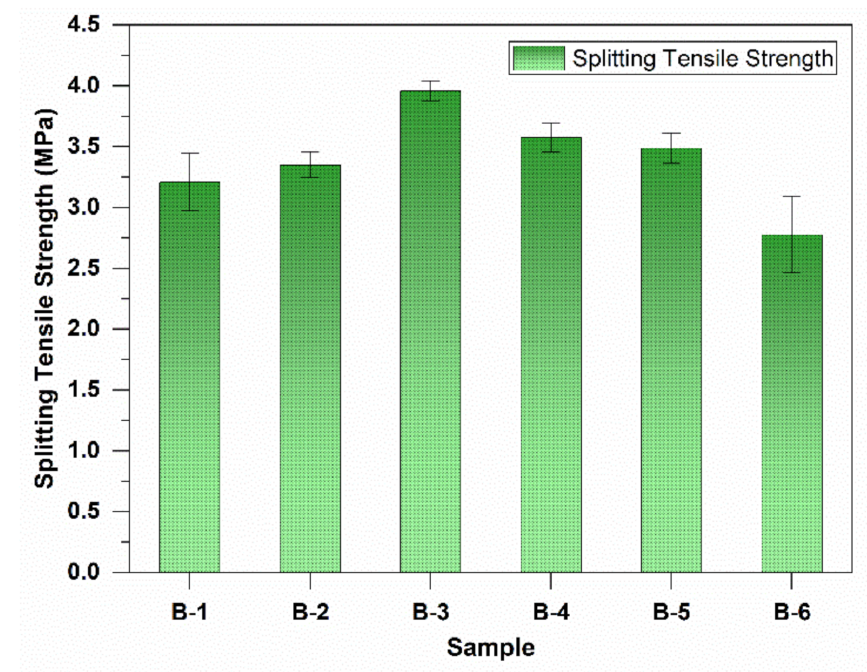
Figure 3. Splitting tensile strength of waste mask-incorporated concrete at 28